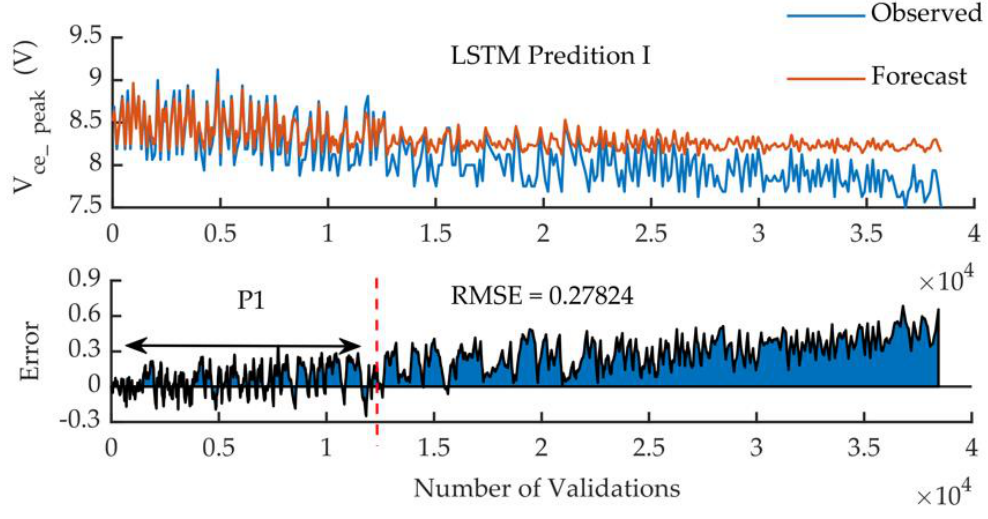
Figure 4. The first LSTM prediction.